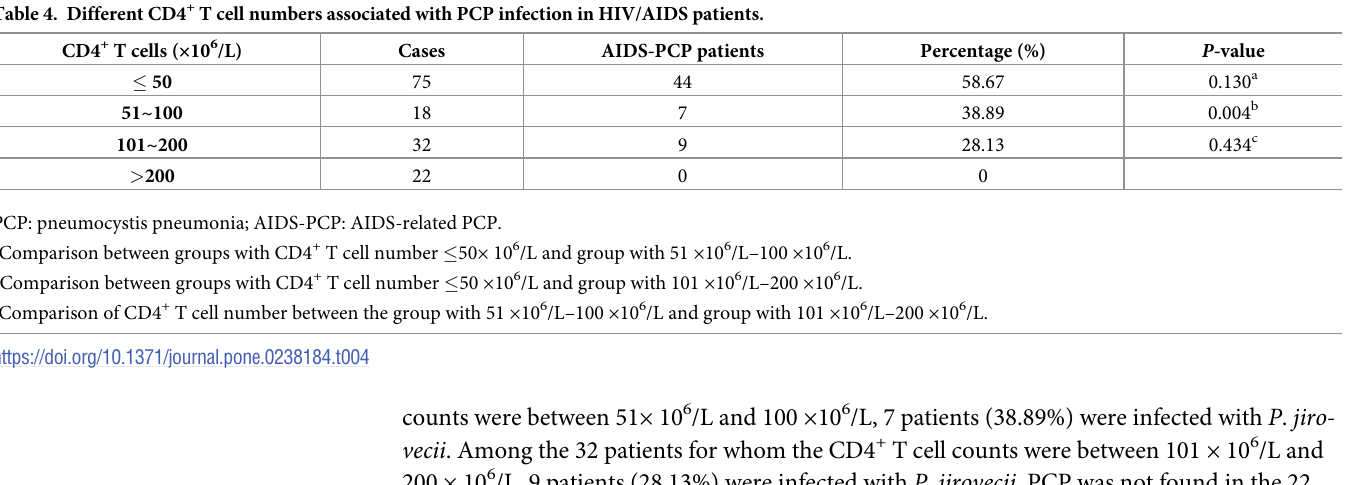
Table 4. Different CD4 + T cell numbers associated with PCP infection in HIV/AIDS patients. CD4 + T cells ( × 10 6 /L)